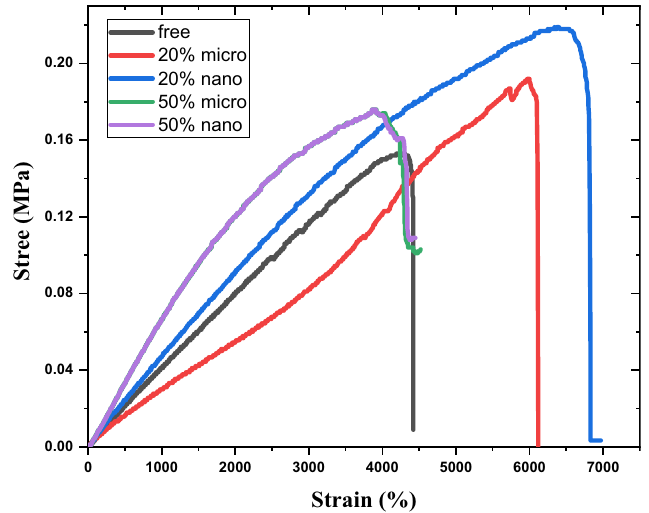
Figure 4. Tensile results of free SR, micro-SnO 2 /SR, and nano-SnO 2 /SR composites.